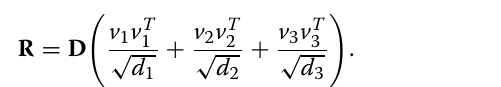
Analytical dual quaternion